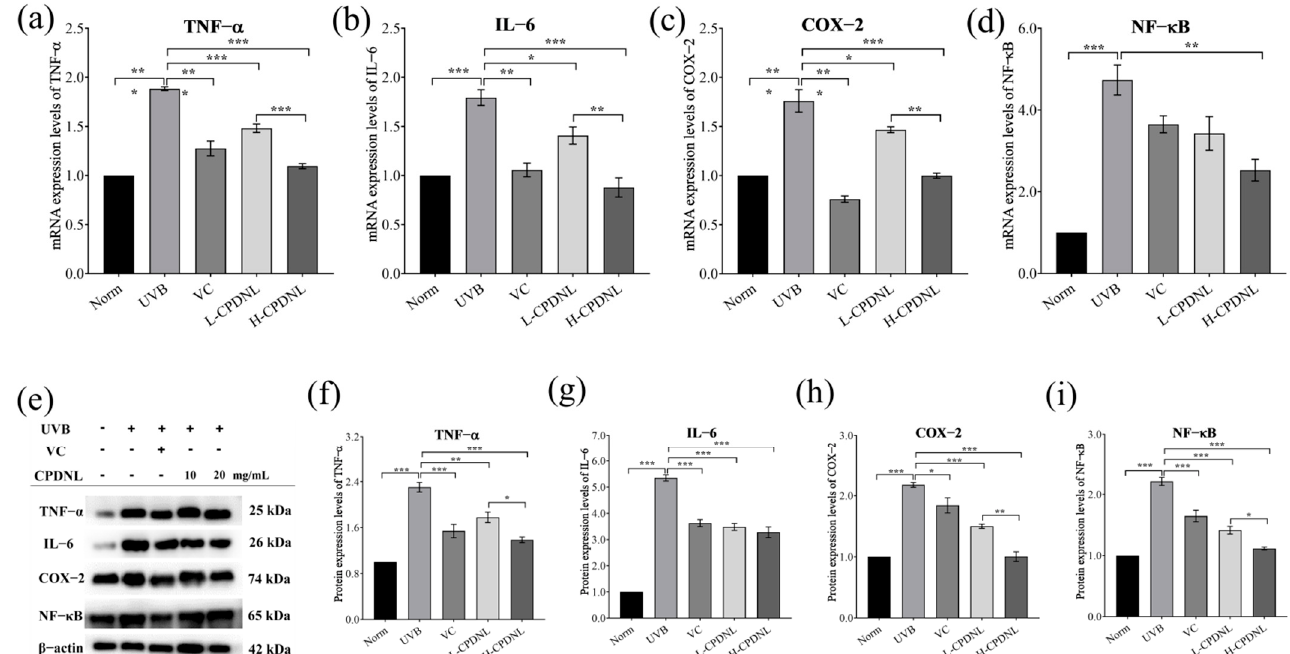
Figure 8. The expression of inflammation cytokines. The mRNA expression of TNF- α ( a ), IL-6 ( b ), COX-2 ( c ), and NF- κ B ( d ) in skin tissue was detected. The protein expression level of inflammation factors ( e ) including TNF- α ( f ), IL-6 ( g ), COX-2 ( h ), and NF- κ B ( i ) was determined by Western blot analysis. Data are presented as mean ± SEM. * p < 0.05, ** p < 0.01, and *** p < 0.001.